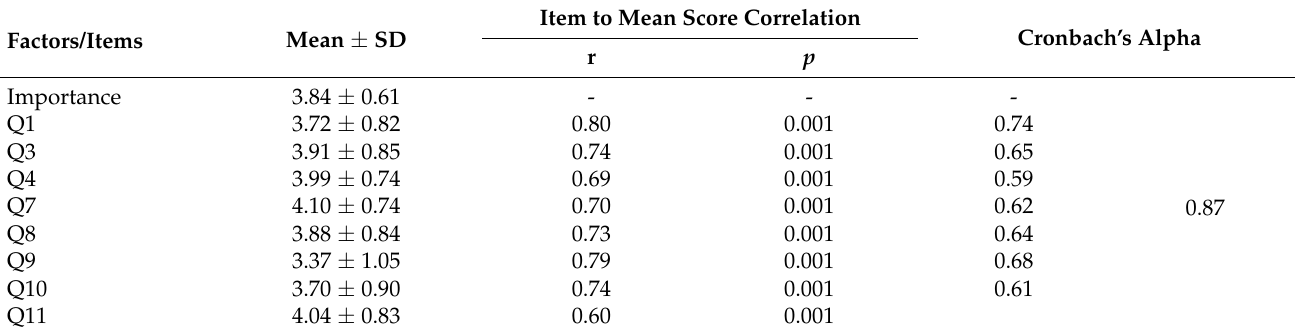
Table 6. Descriptive statistics, reliability, and convergent validity of the PTIDB